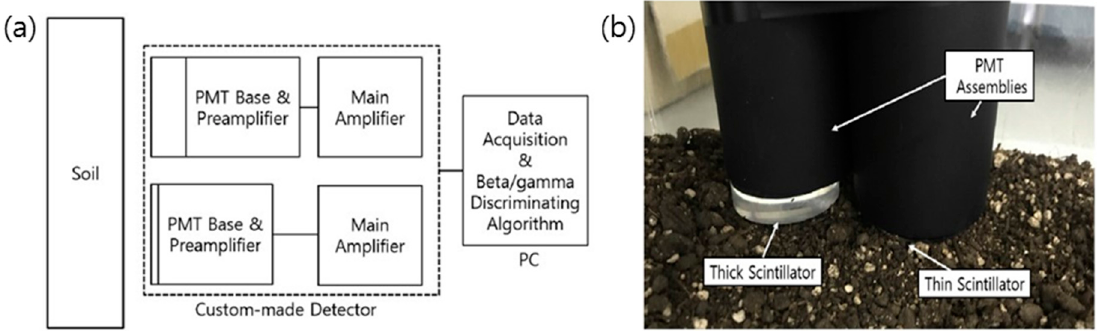
Figure 29. A plastic detector composed with two scintillators: ( a ) conceptual diagram and ( b ) plastic detector bundle [40].